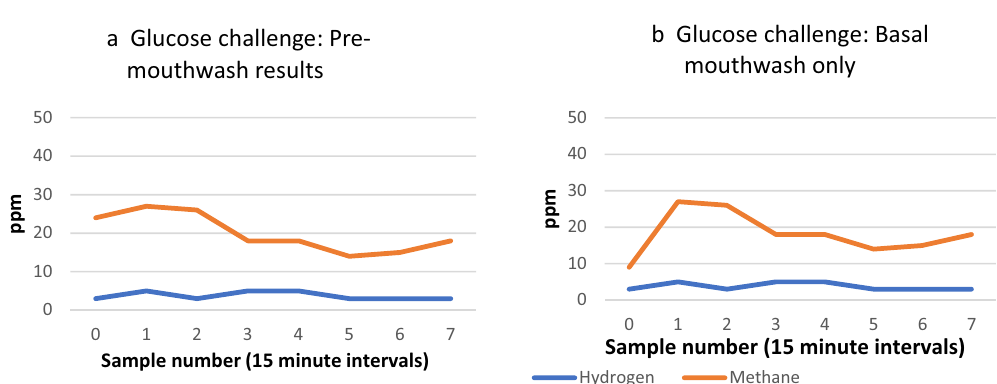
Figure 3. Negative breath test ( a ) becomes positive ( b ) following basal mouthwash during oral glucose